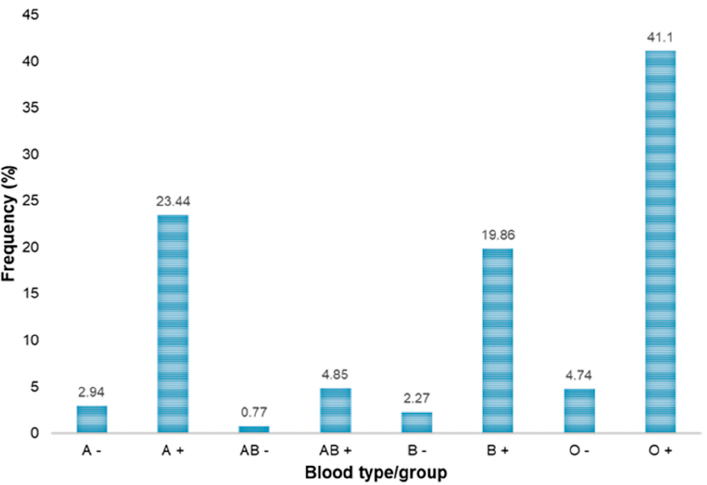
Figure 1. ABO/Rh blood group types of the studied blood donors. Table 1. Demographic characteristics of blood donors who donated blood at KKGH in Al Majmaah city or at the associated blood donation camps in other cities of the region, from January 2019 to